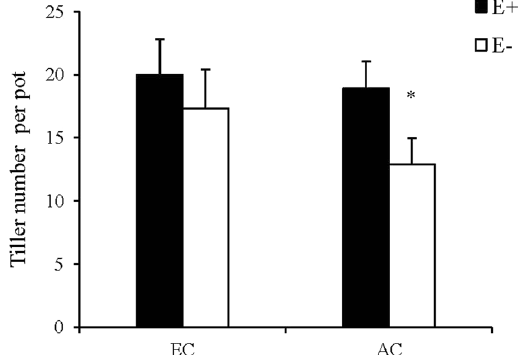
Figure 1. Comparison of tiller number of endophyte-infected (E + ) or uninfected (E − ) Festuca arundinacea under elevated CO 2 (EC) and ambient CO 2 (AC) conditions. * Meant significant difference at 0.05 level.